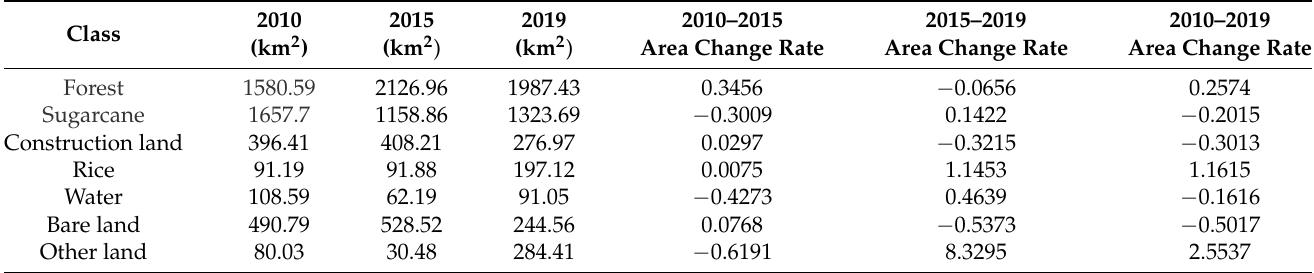
Table 12. Changes in land use types in different periods in Xingbin District, Laibin City,